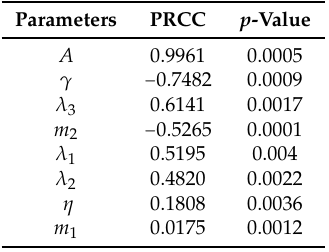
Table 3. The PRCC of the estimated parameters with respect to R